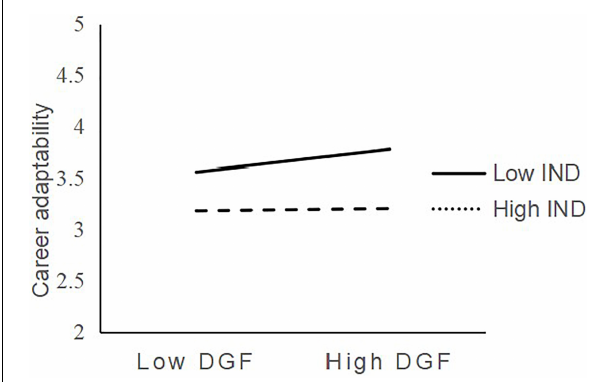
FIGURE 2 | Interaction of desire to gain face and indecisiveness predicting career adaptability.